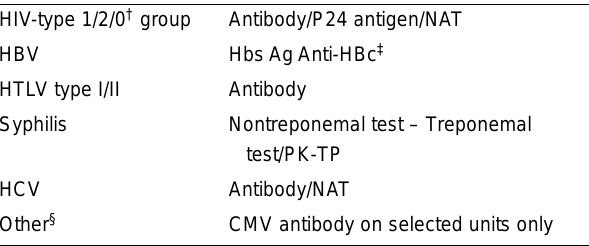
TABLE 1 Testing of blood donors in Canada* by Canadian Blood Services and